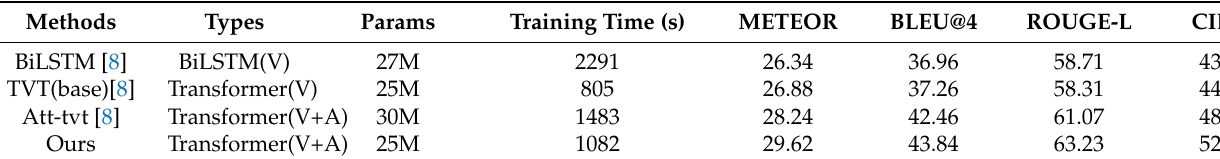
Table 2. Performance comparison of MSR-VTT datasets.